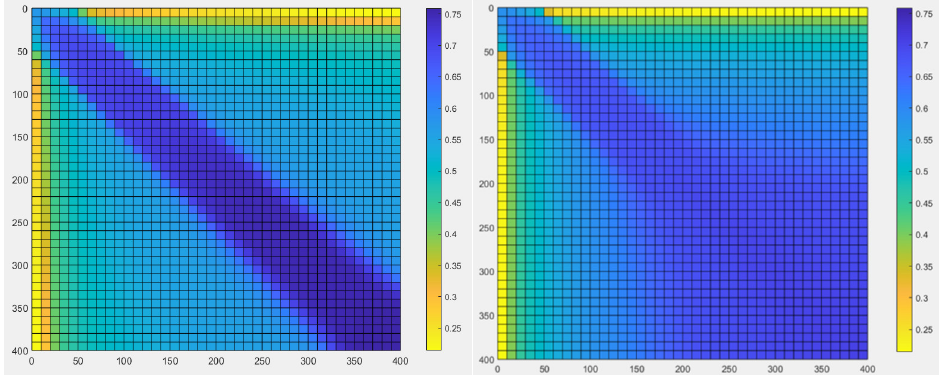
Figure 10. The water saturation distribution at the 50th time step (The left is the numerical simulation results considering the relative permeability of high waterflooding PVs, and the right is the traditional numerical simulation results).